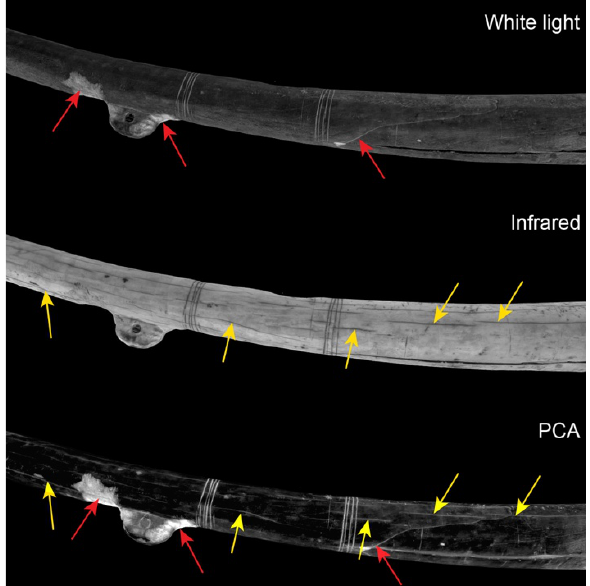
Figure 5: PCA of the spectral data allows to combine features (indicated by the arrows) from both visible and infrared